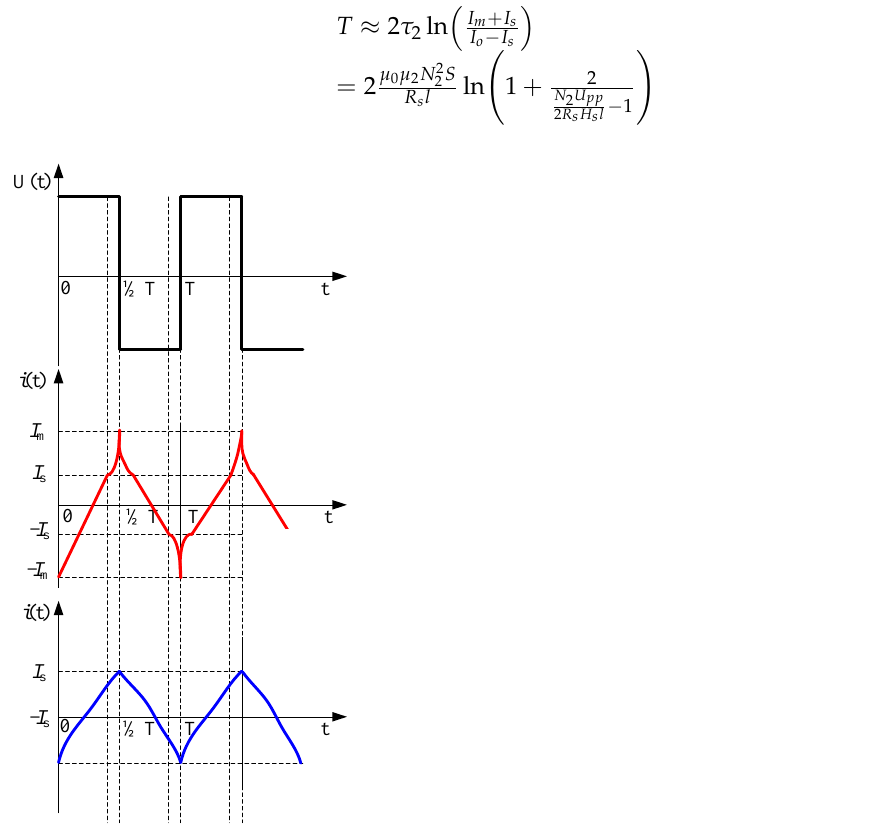
Figure 6. Excitation voltage and current waveform in winding.